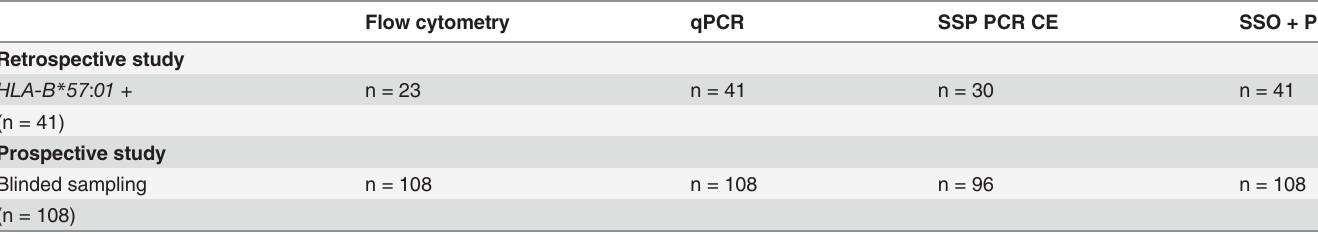
Table 1. Overview of the substudies with patient